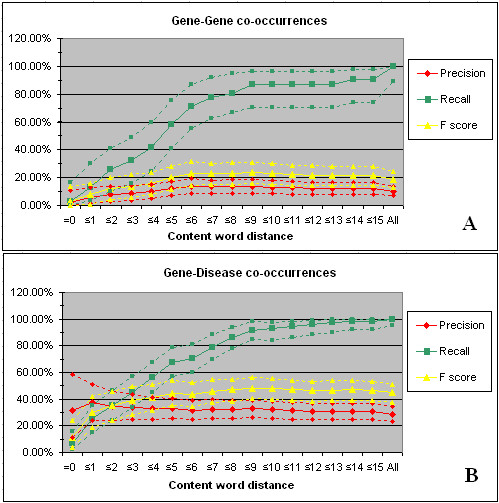
Filtering relations between co-occurring gene-gene or gene-disease terms at increasing number of intervening content words. Content word distance indicates the maximum distance in number of intervening meaningful words between two cooccurring gene-gene or gene-disease terms in the relations retained after filtering. "All" refers to no filtering. Precision (P), Recall (R), and F score (F) were calculated as follows: P = rc/(rc+ri), R = rc/(rc+dc), F = 2*P*R/(P+R) with rc the retained correct relations, ri the retained incorrect relations, and dc the discarded correct relations. Dotted lines indicate limits of 95% confidence intervals.